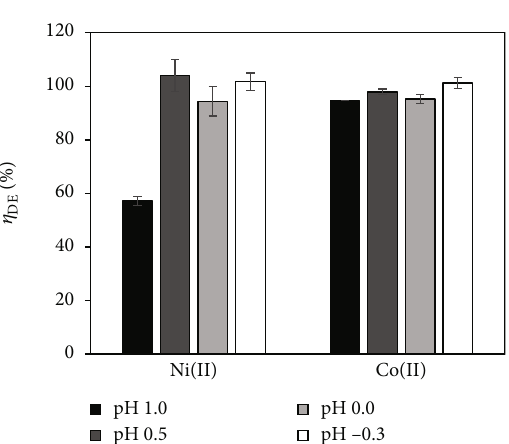
Figure 4: Desorption E ffi ciency ( η ) for Ni(II) and Co(II) at DE T = 20 ° C depending on the pH of the desorption solution (DS). Adsorption loadings before the desorption amounted